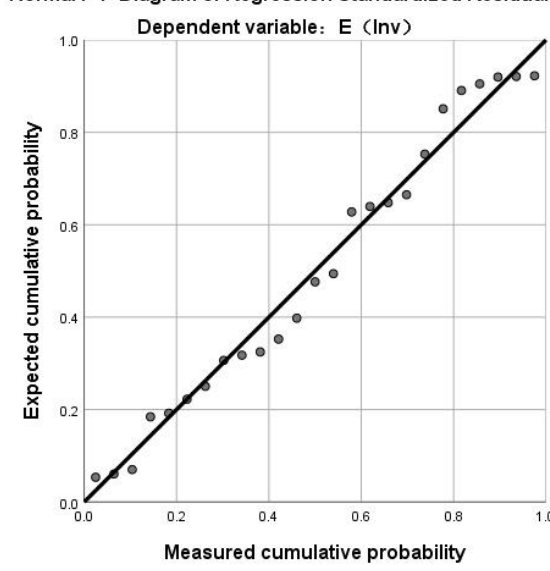
Figure 8. Scatterplot of regression-standardized